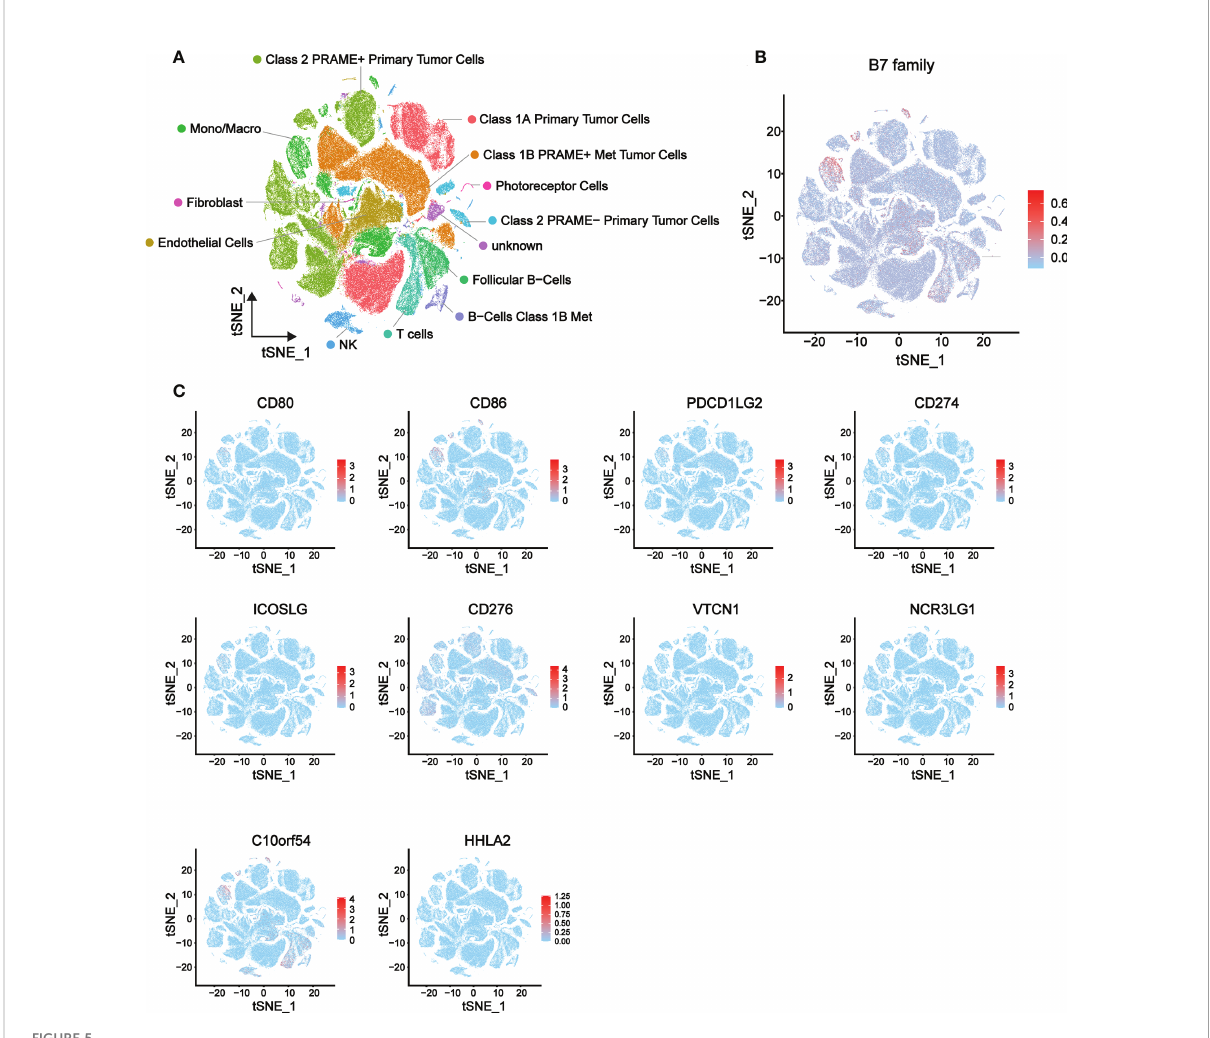
FIGURE 5 Expression distribution of the B7 family in eight primary and three metastatic UVMs from GSE139829 dataset. (A) 13 cell type distribution and the cell type annotations. (B) The overall expression distribution of the B7 family in 13 cell types. (C) The respective expression distribution of the B7 family in 13 cell